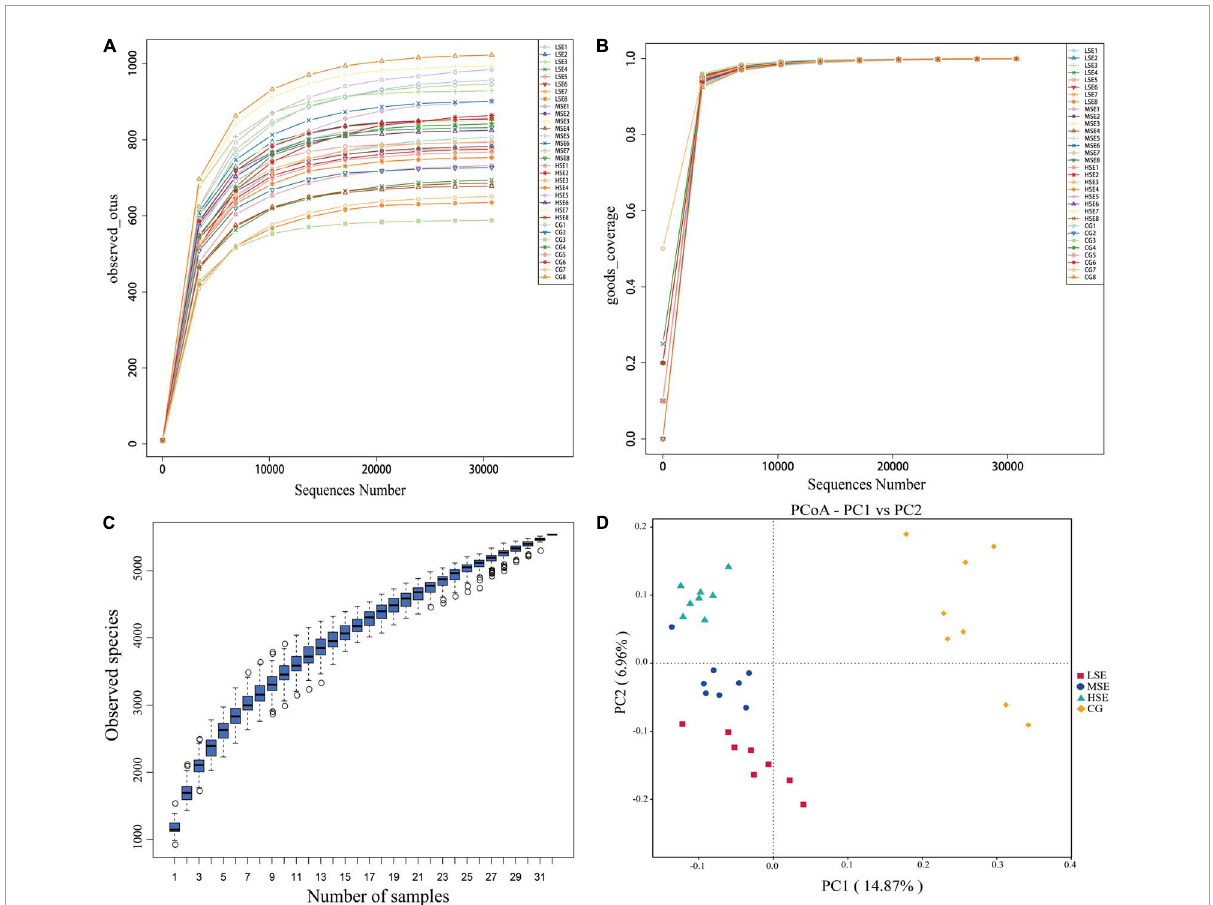
FIGURE2 The alpha- and beta-diversity among four SeHLan supplemented groups. (A) Rarefaction curves based on V3–V4 of 16S rRNA gene; (B) Good’s coverage index; (C) Species accumulation curves; (D) Principal coordinate analysis (PCoA) plot based on Bray-Curtis distance. CG, control group; LSE, low Se group; MSE, medium Se group; HSE, high Se group.